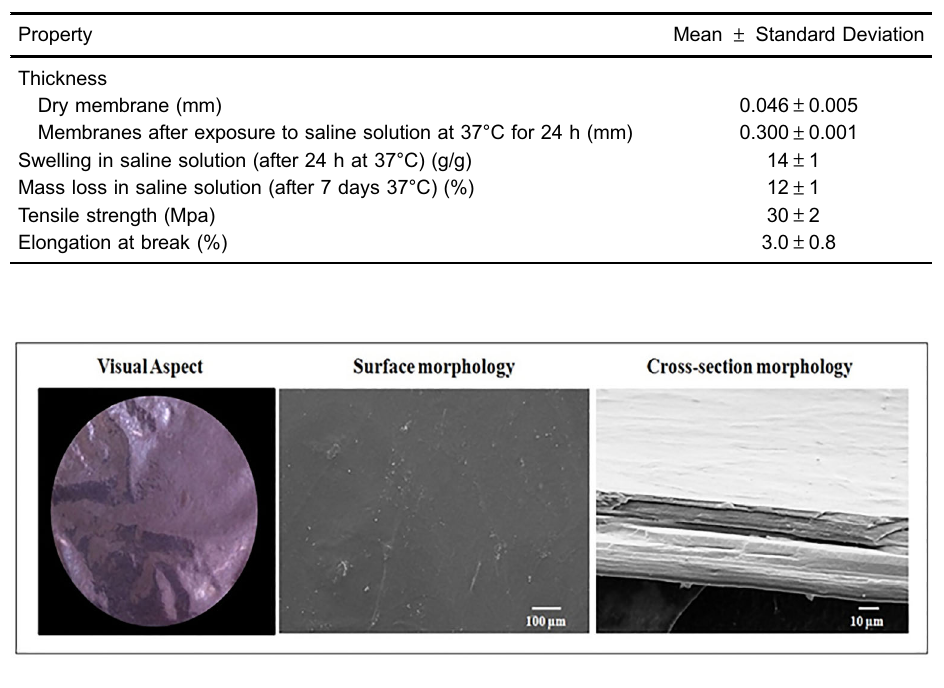
Figure 1. Visual aspect and morphological characteristics of chitosan-alginate